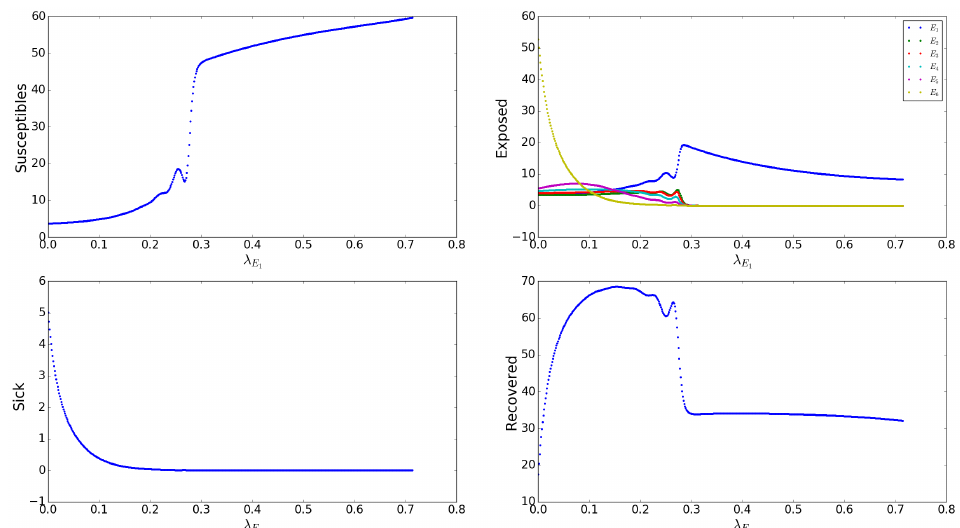
Figure A5. Behaviors of infectious classes relative to the λ (cid:48) s (represented here by λ E The horizontal axes scale the parameter λ E populations. The disease persists for λ E